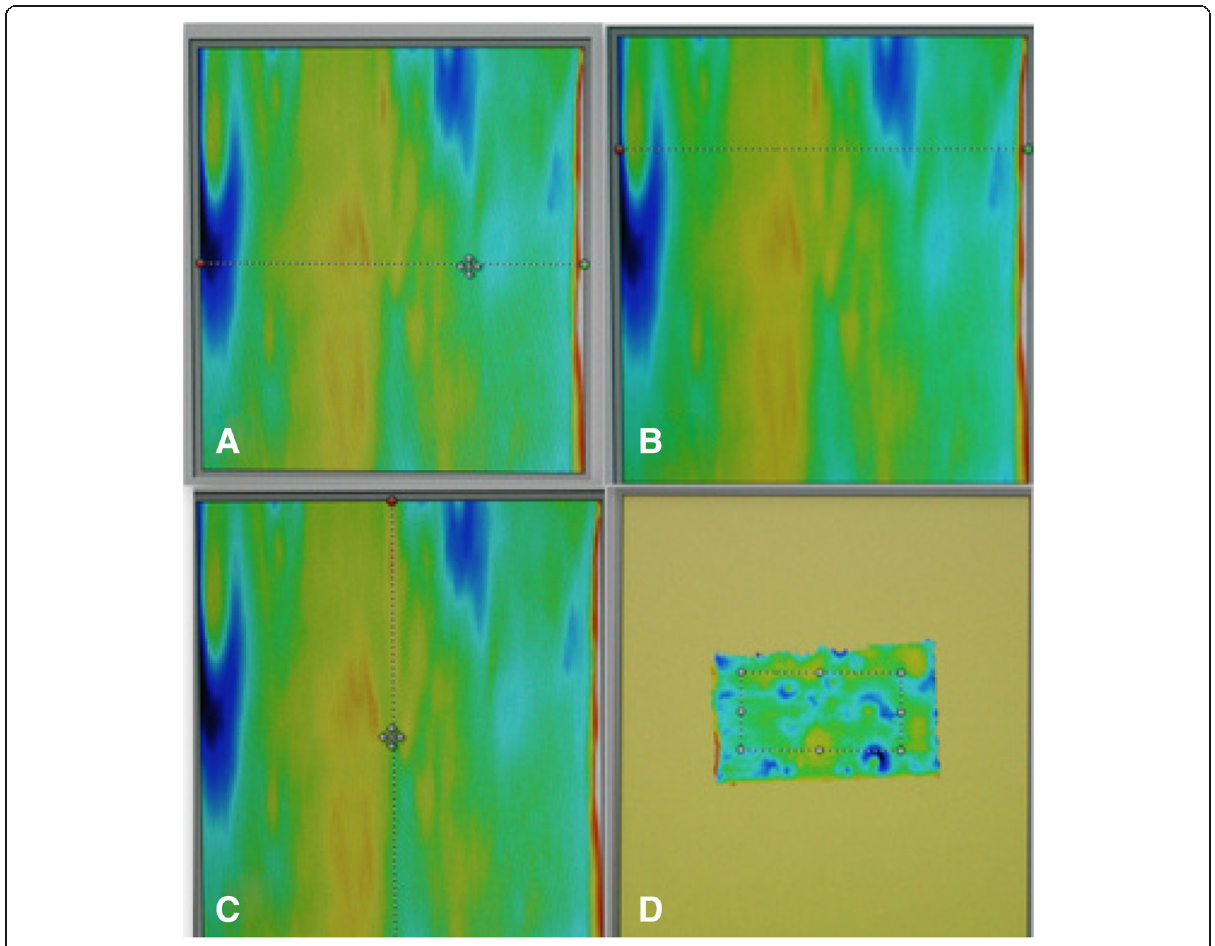
Fig. 7 Showing images of the bracket slot. a – c The profile lines indicate average roughness (Ra) which is two-dimensional. d The marked rect- angular area as a whole indicates the average surface roughness (Sa) which is